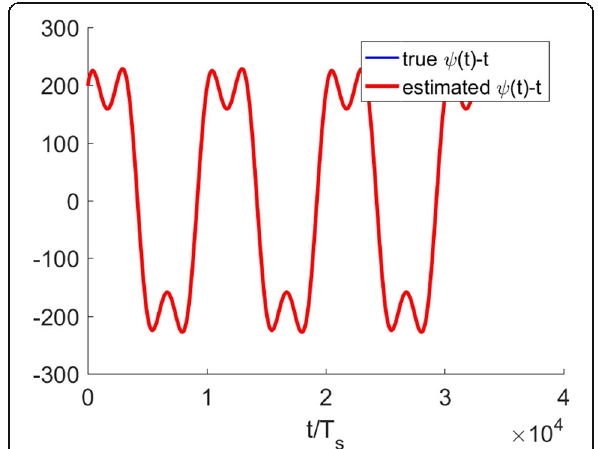
Fig. 2 Case A: time-warping function deviation ( ψ ( t ) − t )/ T s (blue), and estimate ð ^ ψ ð t Þ − t Þ = T s thereof (red), using inexact warping frequencies with SNR ¼ 10 dB. Case B: for exact warping frequencies and SNR ¼ − 10 dB, results are graphically indistinguishable from those shown for case A